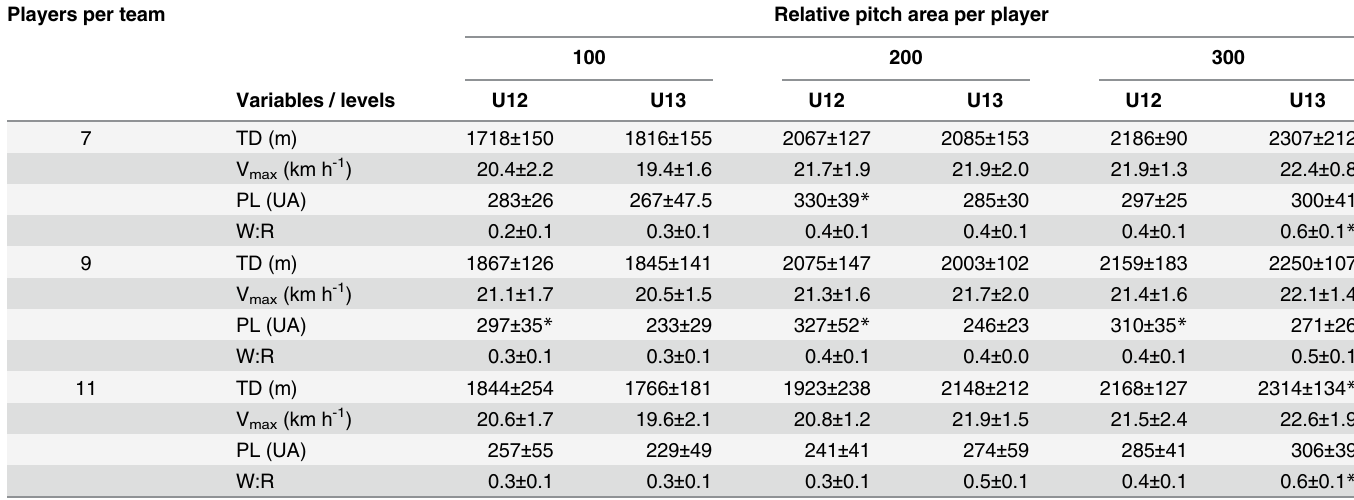
Note: 100, 200, and 300 represent, respectively, the relative pitch areas of 100 m 2 , 200 m 2 , and 300 m 2 per player, while 7, 9, and 11 correspond to the number of players per team (7, 9, and 11, respectively). U12 is players aged under 12 years and U13 under 13 years. * Signi fi cant difference between categories p <